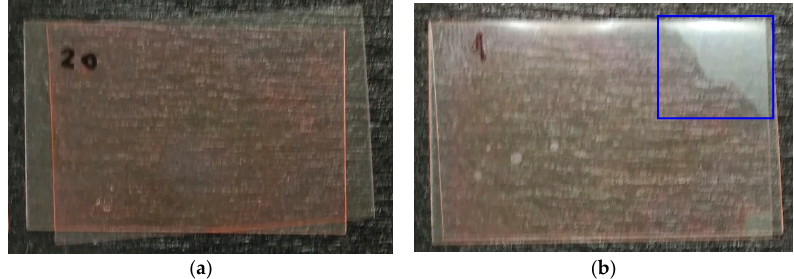
Figure 4. ( a ) Example of homogeneous photopolymer layer on the polyester surface. ( b ) Example of non-homogeneous photopolymer layer with an uncovered area inside the blue rectangle on the polyester surface.